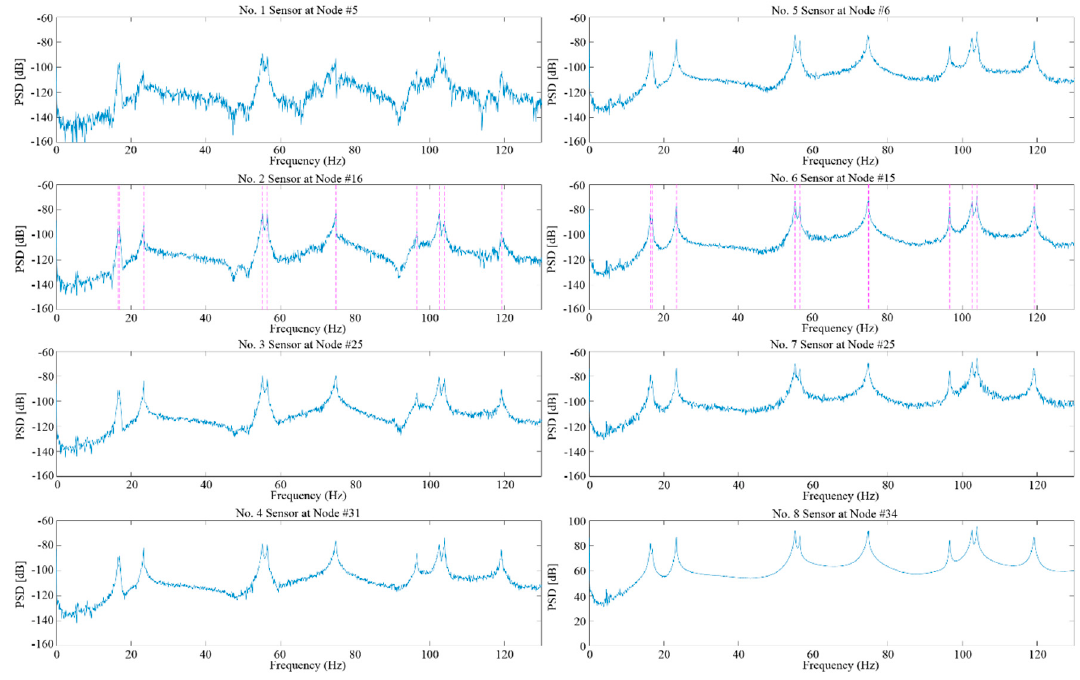
Figure 7. Experimental frequency responses of some typical OSP nodes in the MOP results.